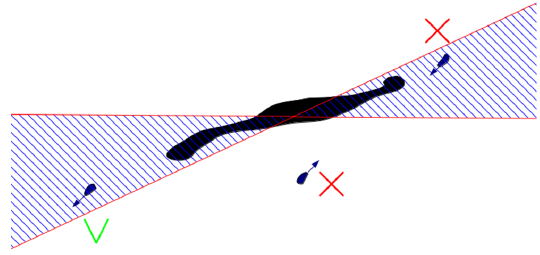
Figure 19. Example of an oil spill and three ships with their directions (blue arrows). The red cross means that the corresponding ship cannot be a candidate and vice versa for the green V.